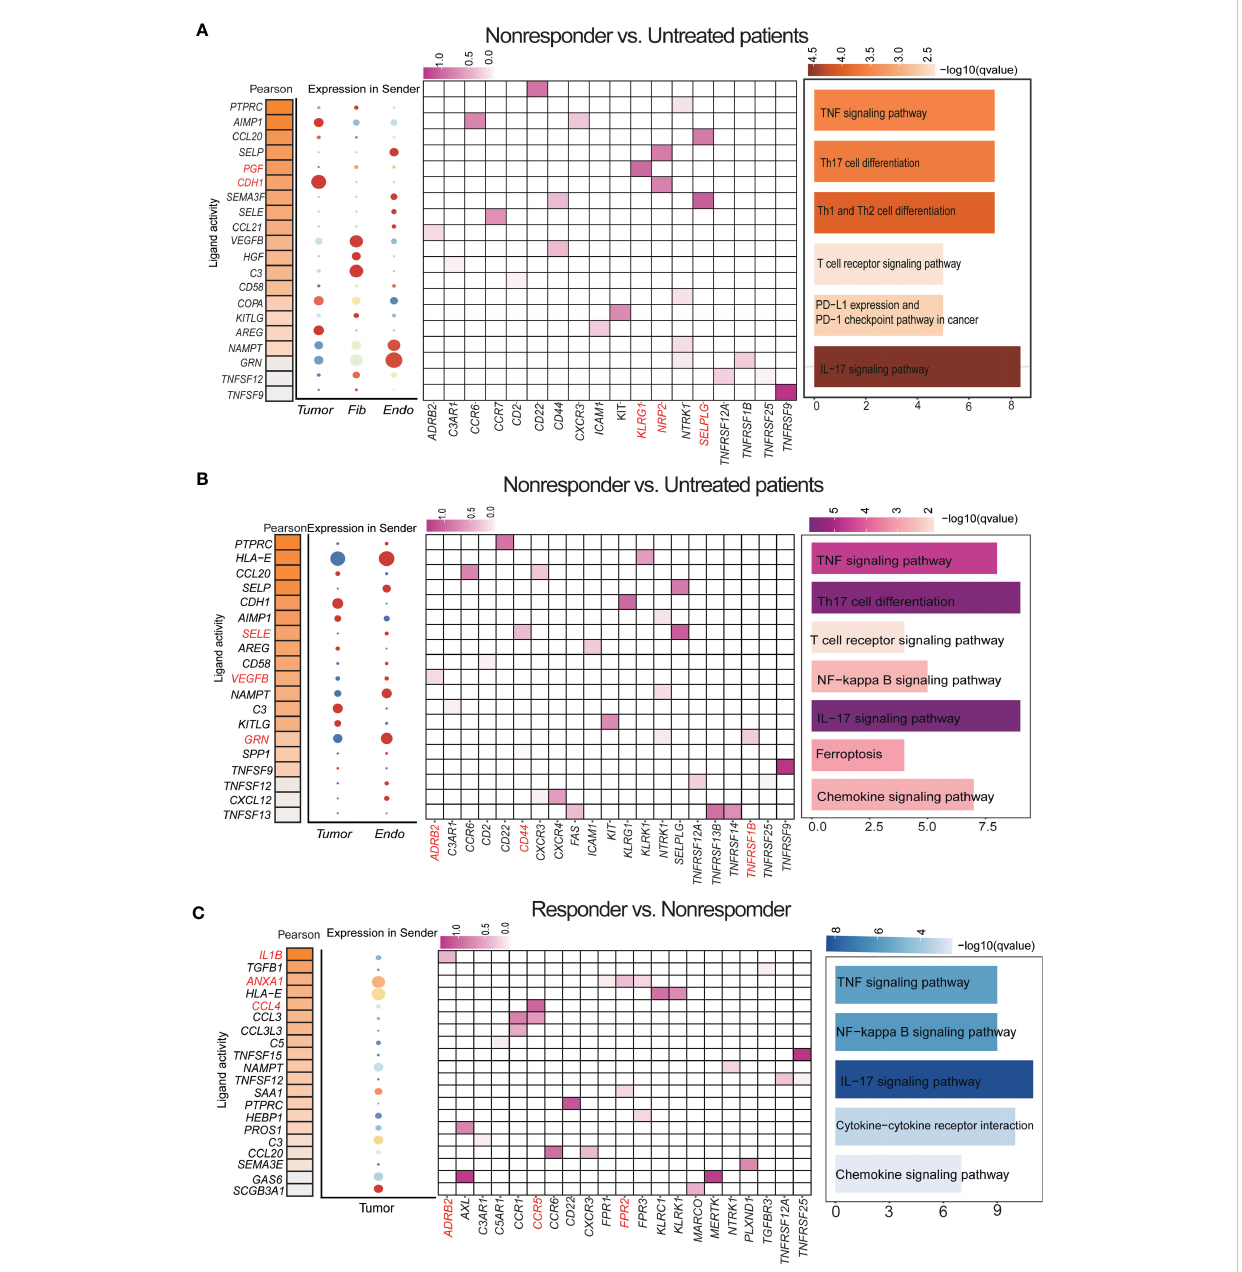
FIGURE 4 Single-cell transcriptional analysis reveals the cell − cell crosstalk network in LUAD. (A) By comparing differences between nonresponders vs untreated patient cell interaction receptors and ligands in several key cell types. (a) Ligand activity prediction by “ NicheNet ” showing the top 20 ligands best predicting all DEGs between sender and receiver cells. (b) The bubble plot shows the expression patterns of the predicted ligands on tumor cells, endothelial cells, and fi broblasts. (c) Ligand – target matrix displayed in LUAD. (d) Representative KEGG pathway enrichment of the predicted target genes expressed. Statistical analysis was performed by Fisher ’ s test. (B) By comparing differences between responders vs untreated patients, cell interaction receptors and ligands in several key cell types. (C) Cell interaction receptors and ligands in several key cell types were compared between responders and